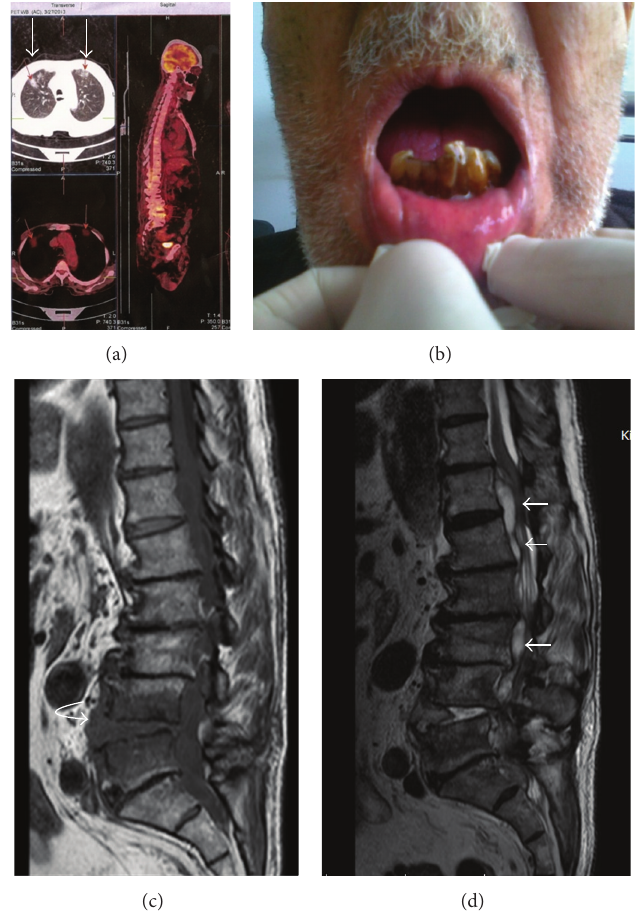
Figure 1: (a) PET-CT image of the patient showing pulmonary and lumbar vertebral involvement (arrows). (b) Poor orodental hygiene of the patient of heavy smoking hand-rolled tobacco. (c) T1 weighed sagittal MRI of the spine showing edema and postcontrast involvement in L4-5 vertebral bodies and postcontrast uptake L4-5 intervertebral disc (arrow) and adjacent iliopsoas muscle (not shown in this image). (d) T2 weighed sagittal MRI reveals epidural fluid with an 8mm width at most between T12 and S1 vertebrae, in an unconnected extension with peripheral contrast involvement. There are a marked spinal cord and neural foraminal compression (arrows). Actinomyces israelii was isolated from the culture of the abscess and disc